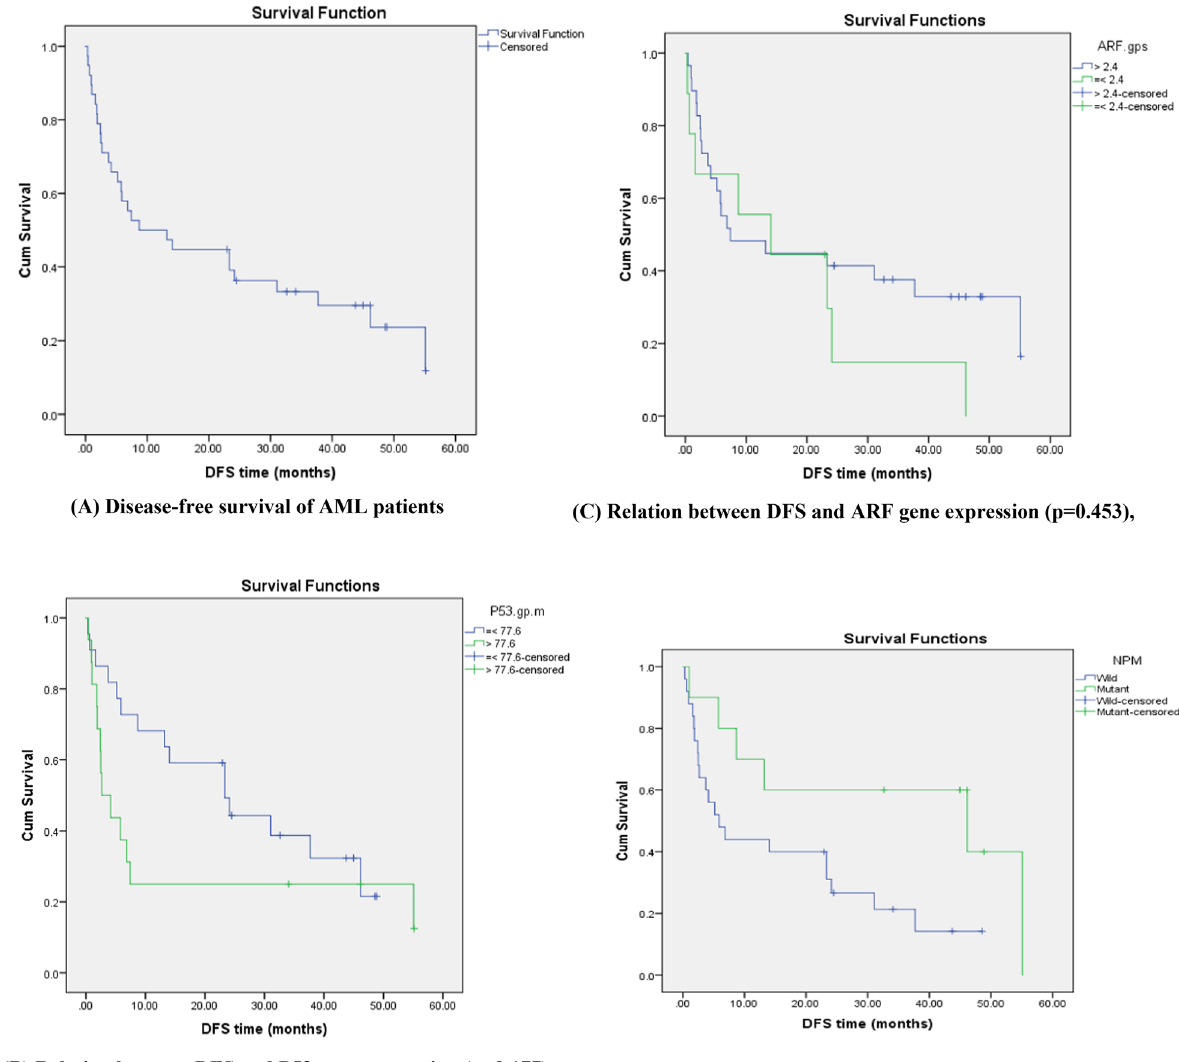
Fig. 3 Kaplan–Meier curve of Disease-free survival analysis in relation to genes